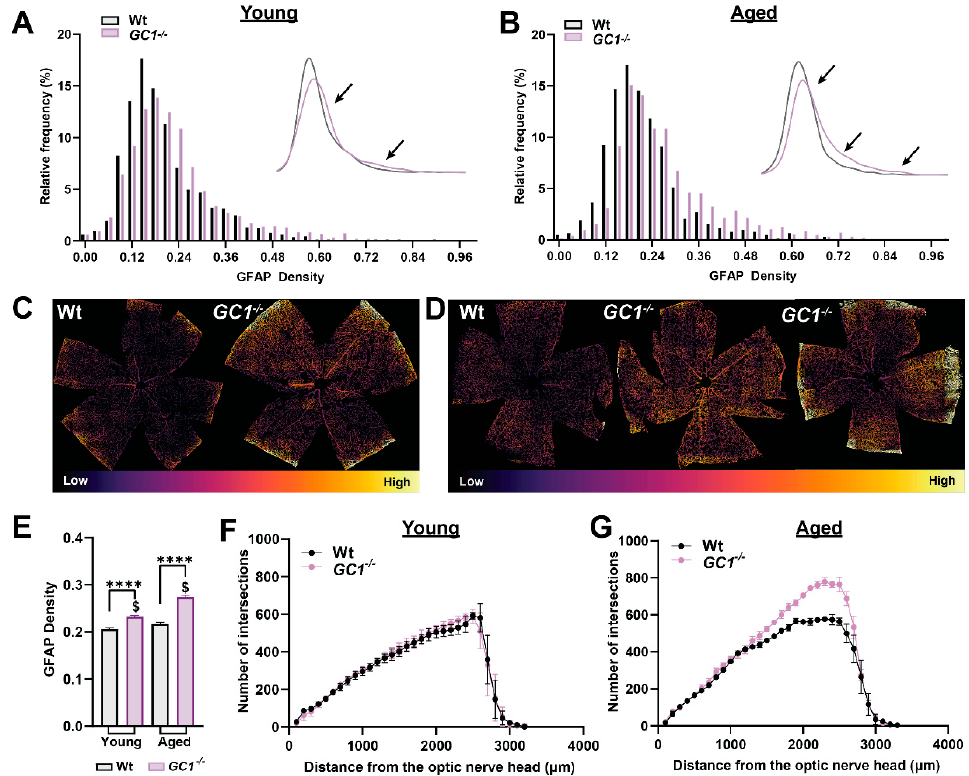
Figure 5. Astrocyte density is increased in GC1 − / − retina. ( A ) Histogram plots of GFAP density across whole retinas of young Wt and GC1 − / − animals ( n = 8 Wt, n = 10 GC1 − / − ). The subplot shows a kernel density estimation plot for clarity; arrows signify differences in distributions between genotypes. ( B ) Histogram plots of GFAP density across whole retinas of aged Wt and GC1 − / − animals ( n = 3 Wt, n = 4 GC1 − / − ). The subplot shows a kernel density estimation plot for clarity; arrows signify differences in distributions between genotypes. ( C ) Representative retinas of young Wt and GC1 − / − mice recolored according to relative GFAP density. ( D ) Representative retinas of aged Wt and GC1 − / − mice pseudo-colored according to relative GFAP density; arrows point to areas of increased density. ( E ) Bar plot comparing GFAP densities between all groups. Data plotted as mean ± SEM. (**** p < 0.0001 and $ p < 0.0001). ( F ) Scholl analysis of binarized GFAP in young mice and ( G ) aged mice. Statistical analysis carried out was Kruskal–Wallis one-way